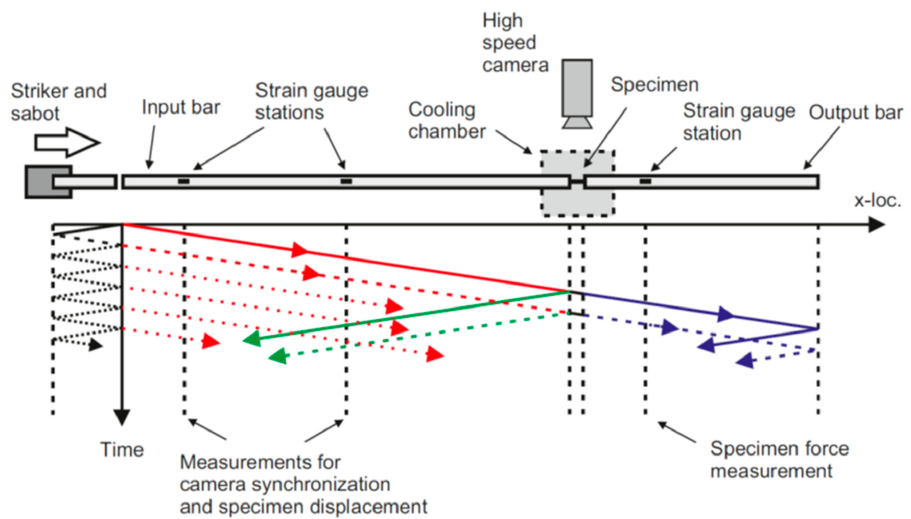
Figure 2. Schematic illustration of the components of the SHPB setup and the relevant wave motion within the bars during the test. The left hand strain gauge on the input bar is referred to as strain gauge 1, the right hand strain gauge on the input bar is referred to as strain gauge